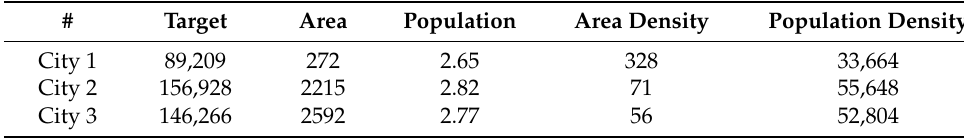
Table 2. Targets in cities with their geographical information. For a targeted city, the “target” represents the number of targets, “area” provides the area in square kilometers, “population” refers to the population in millions of people, “area density” refers to the number of targets per square kilometer, and “population density” refers to the number of targets per million